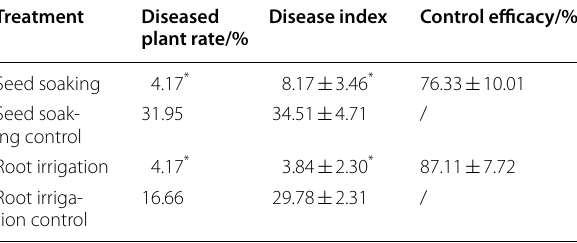
Data are mean SD; * indicates that there is a significant difference between the ± treatment and the control ( P < 0.05)